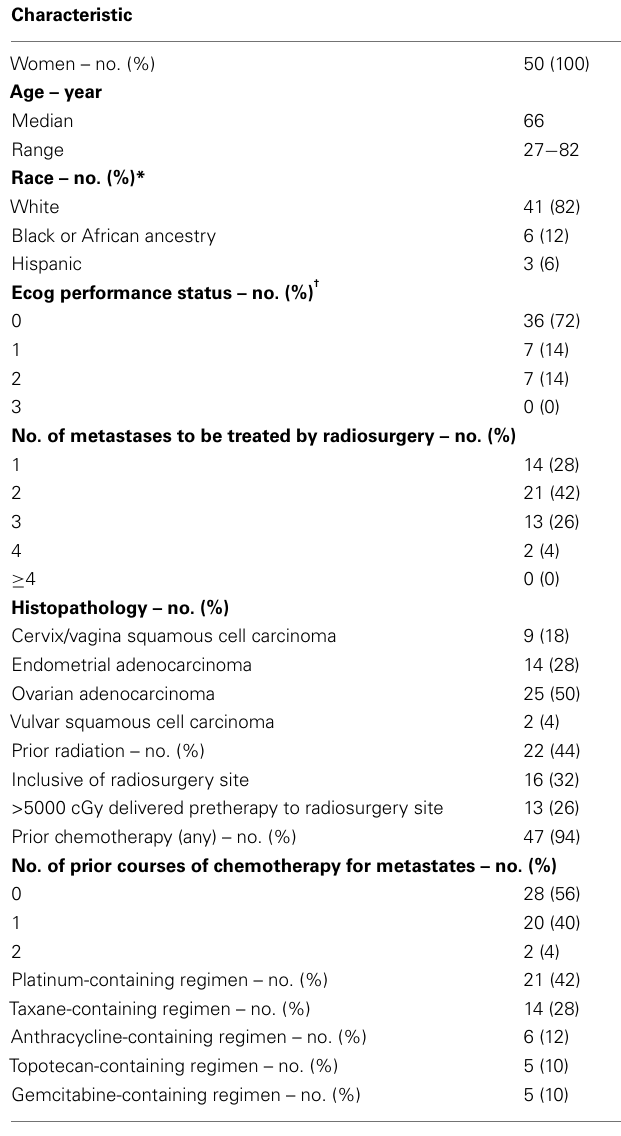
Table 1 | Baseline characteristics of the study